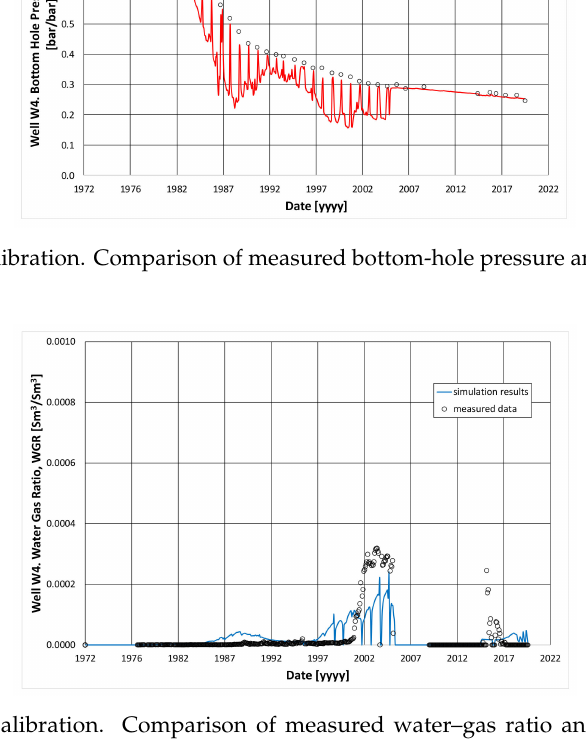
Figure 18. Model calibration. Comparison of measured water–gas ratio and simulation results. Well